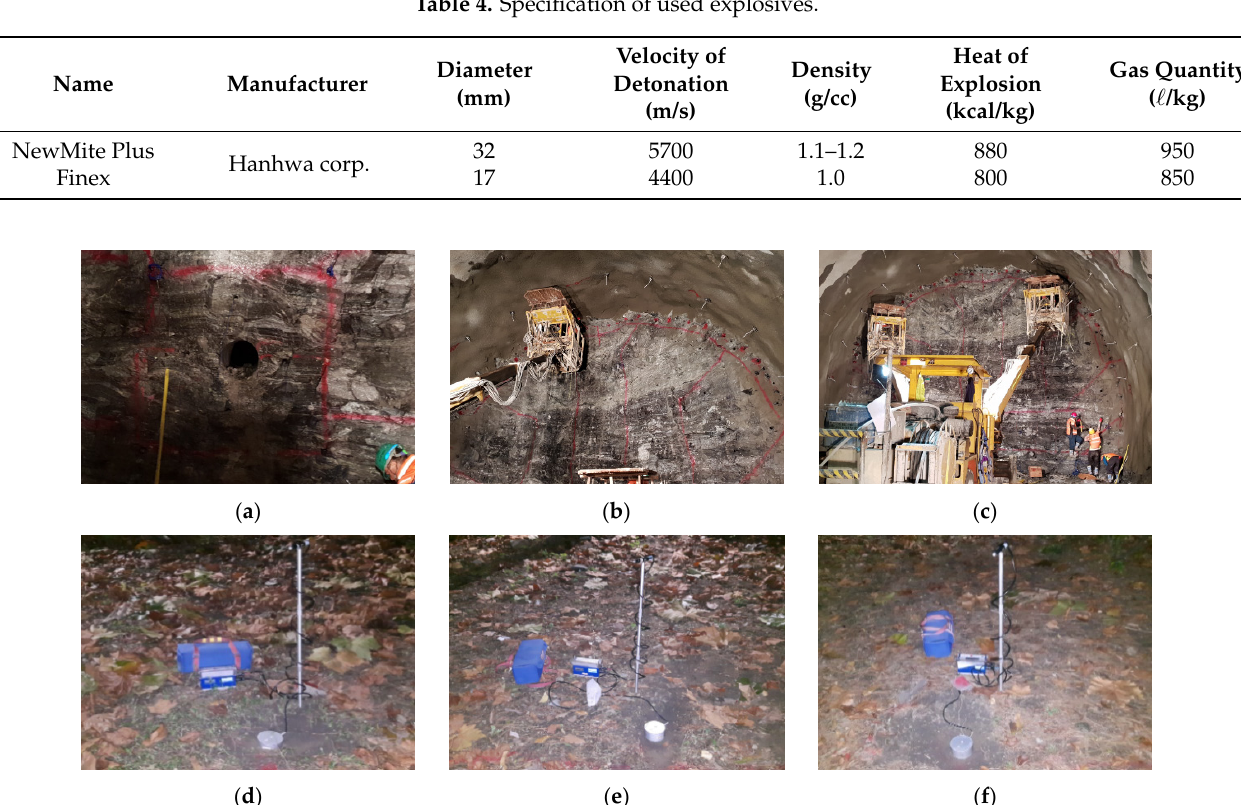
Figure 7. Images of the construction site and installation of vibration monitoring system: ( a ) single-MSP, ( b ) drilling contour holes, ( c ) charging, ( d ) vibration monitoring-1, ( e ) vibration monitoring-2, and ( f ) vibration monitoring-3.